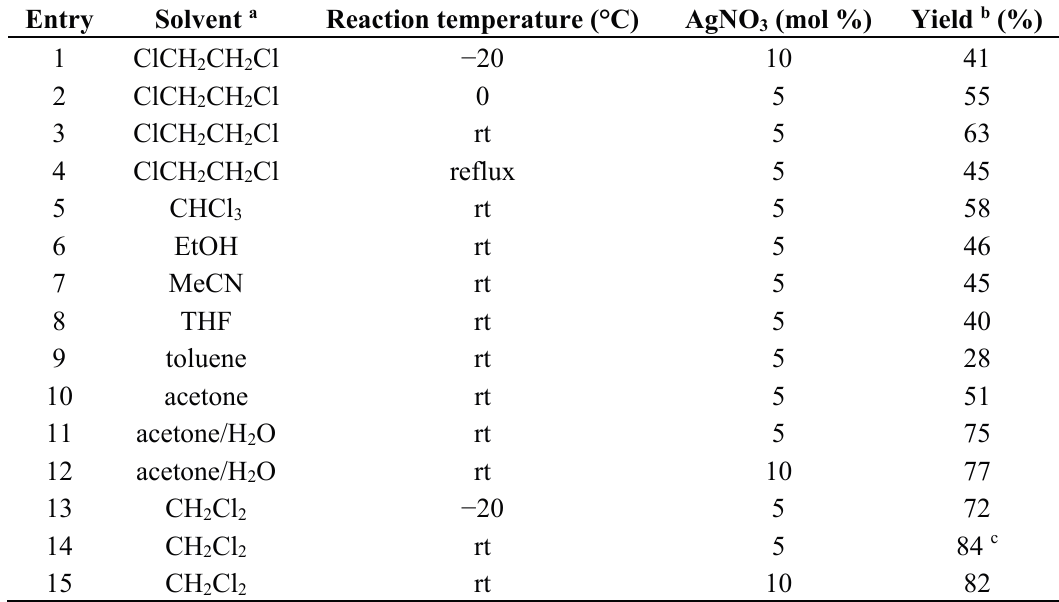
Table 1. Optimization of the AgNO 3 -catalyzed cycloisomerization of the model